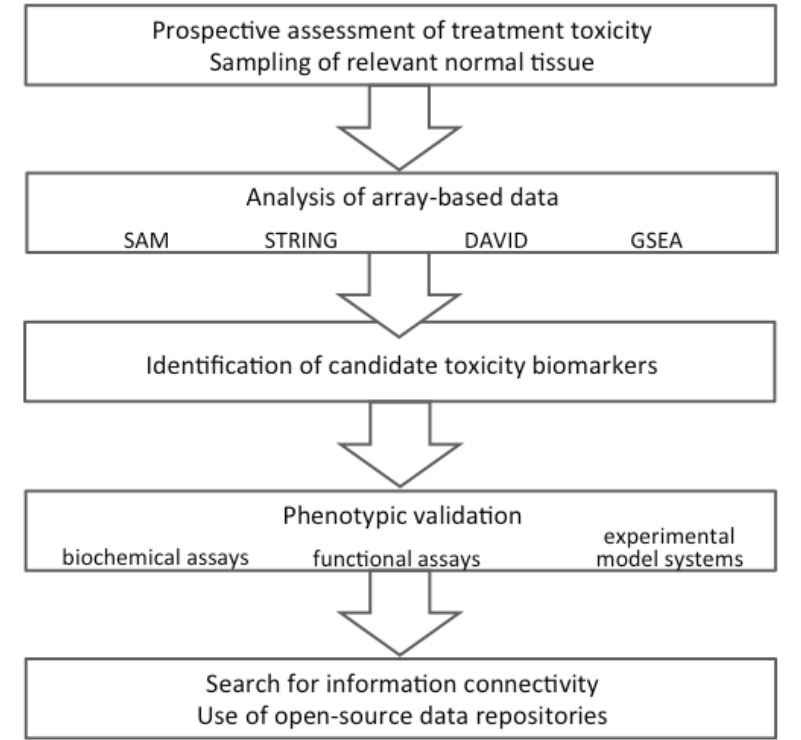
Figure 4. Mechanism-based prediction of treatment toxicity—an example. SAM: Significance Analysis of Microarrays; STRING: Search Tool for the Retrieval of Interacting Genes/Proteins; DAVID: Database for Annotation, Visualization and Integrated Discovery; GSEA: Gene Set Enrichment